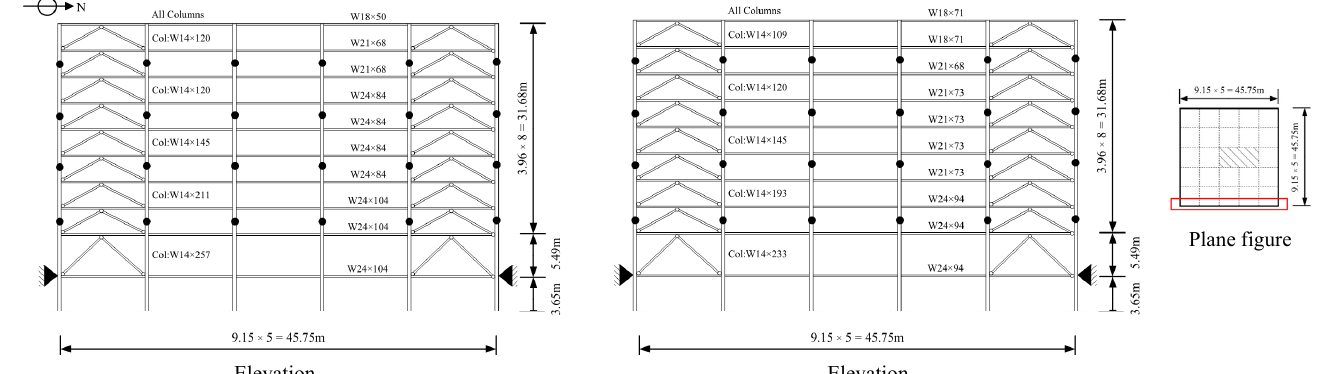
Figure 13. Nine-story prototype building.